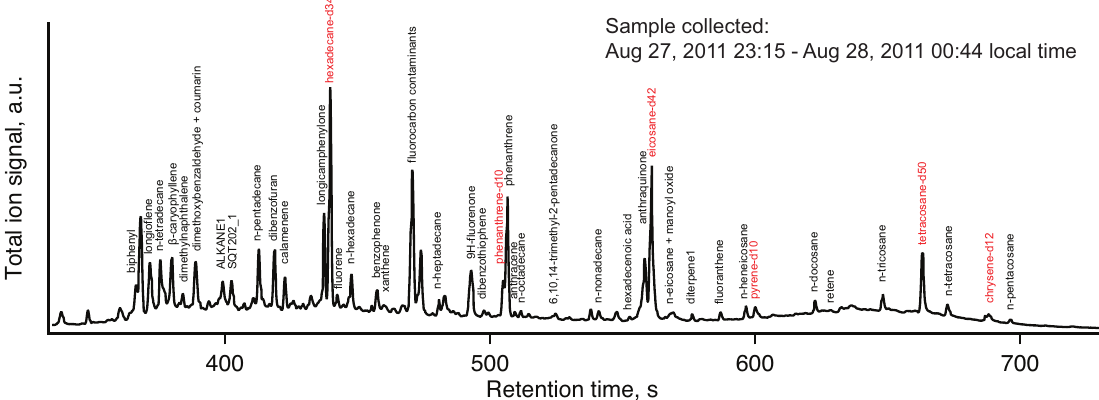
Figure 2. Total ion chromatogram of a typical sample. Deuterated internal standards (labeled in red) were injected prior to thermal desorption. The labeled compounds represent a subset of the compounds identified. More compounds were identified using the selected ion traces. A partial list of compounds tentatively identified is shown in Table 1, and the full list is shown in Table S1 in the